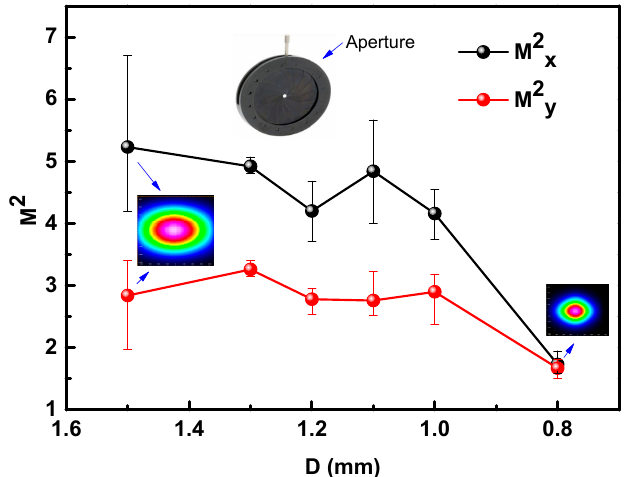
Figure 9. Dependences of the beam quality M 2 factors of the green laser in x and y directions on the aperture diameter size D at 25 W input power. The inset is the green beam profile at D = 1.5 mm and 0.8 mm, and with the aperture used in this experiment.